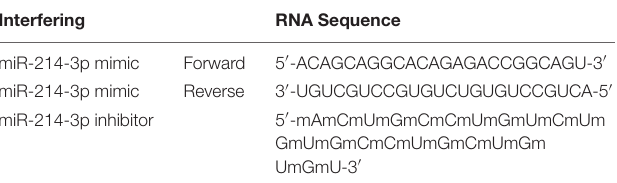
TABLE 1 | Interfering RNA sequence. Interfering RNA Sequence miR-214-3p mimic miR-214-3p mimic